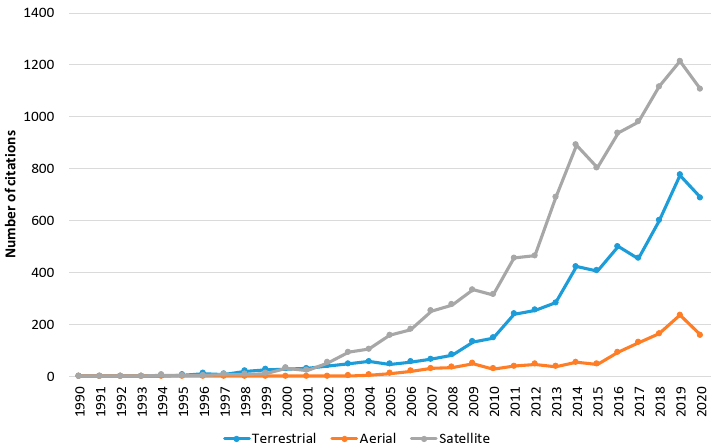
Figure 8. The number of times cited the published articles per year for terrestrial, aerial, and satellite-based systems. The analysis was performed for forest fire detection in the imaging research area. Data retrieved from Web of Science [134] for dates between 1990 to October 2020.